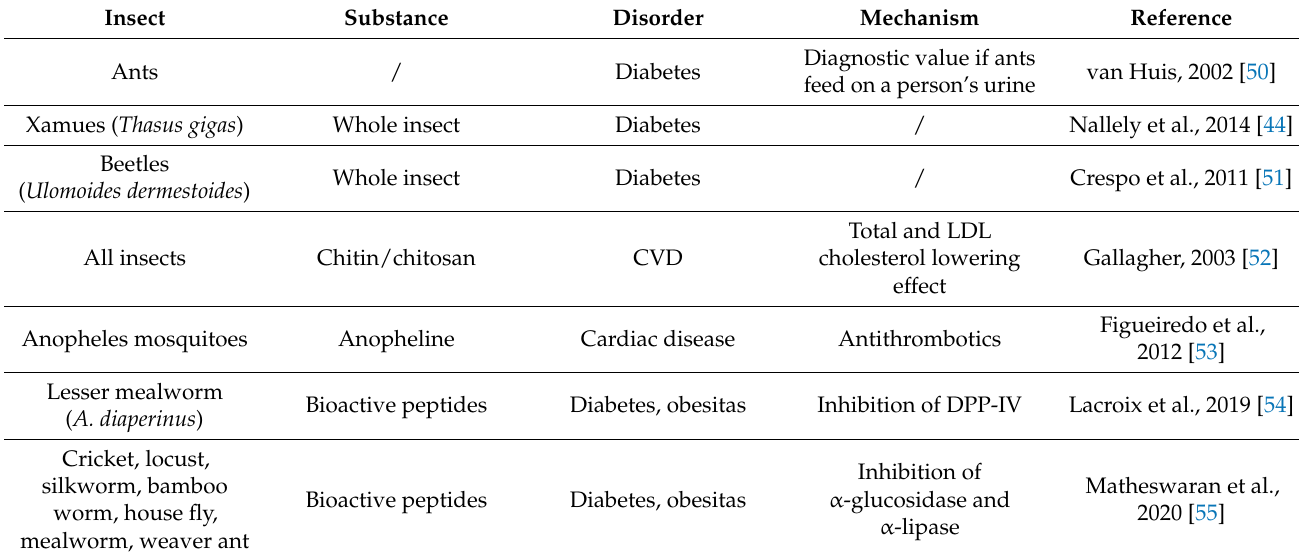
Table 4. Overview on the medicinal use of insects and derived products for diabetes or associated complicating